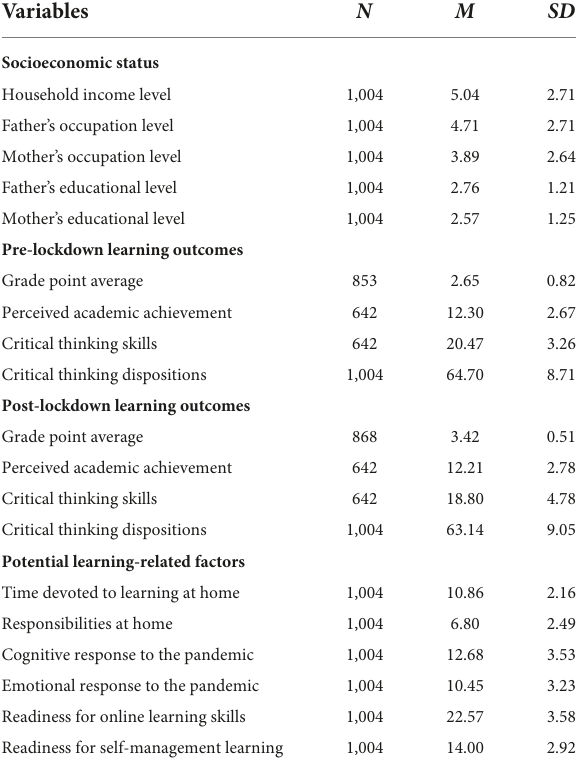
TABLE 1 Descriptive statistics for all variables of the